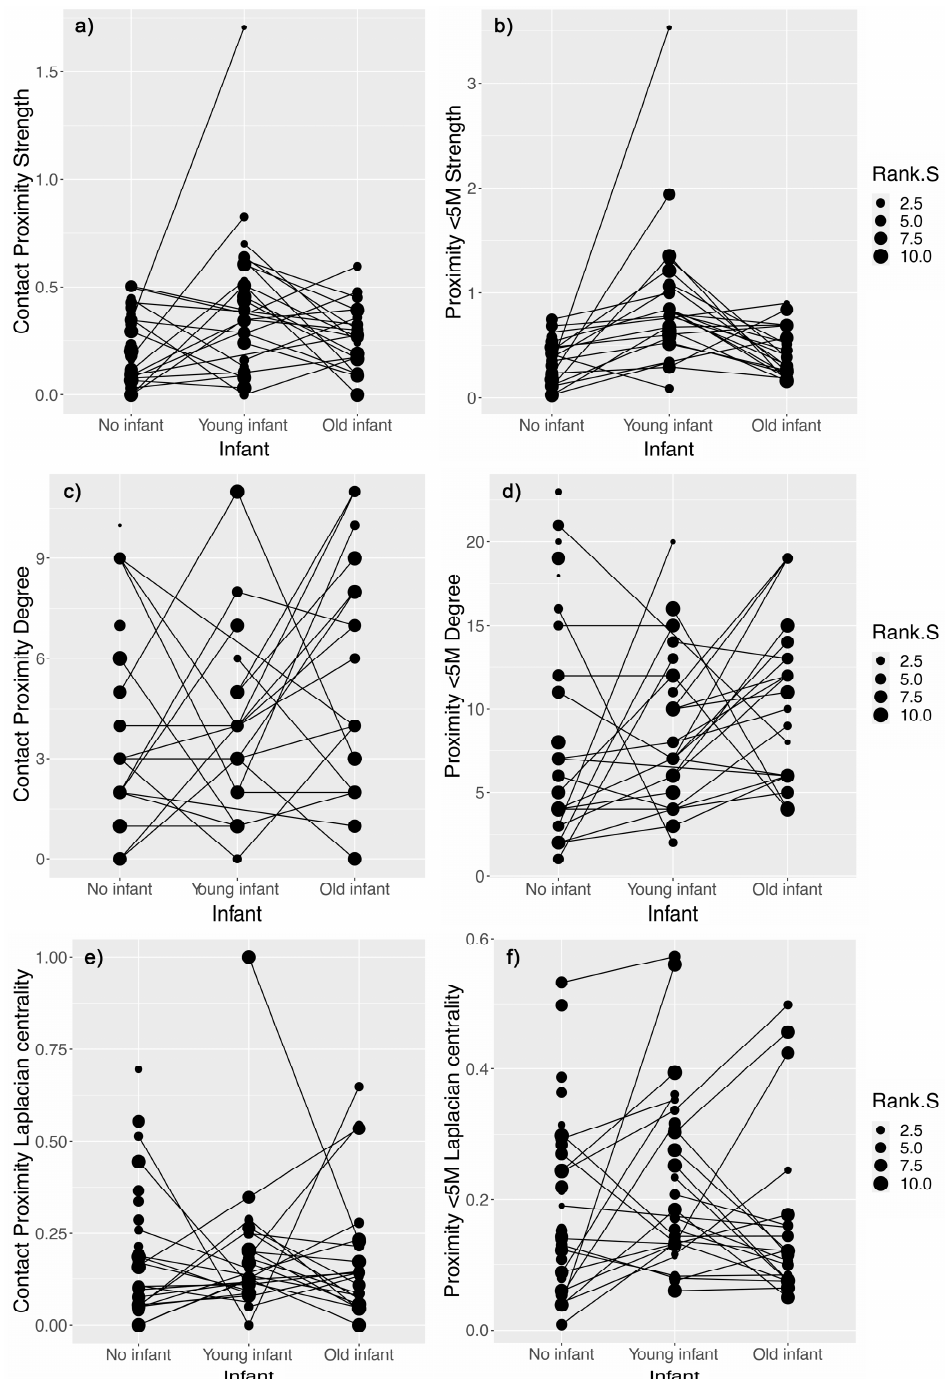
Figure 1. Comparison of the ( a,b ) frequency in association ( Strength ), ( c , d ) number of female neighbors ( Degree ) and ( e , f ) connectivity power ( Laplacian centrality ) between female nursing conditions (No infant (NN) vs Young infant (YI) vs Old infant (OI) females) of the contact- ( a,c,e ) and 5 m proximity networks ( b,d,f ). Node size reflects the hierarchical rank (the lowest values represent the highest-ranking individuals). The lines represent the same individual experiencing different nursing conditions in the course of the study. Because several individual data points could overlap, more than two lines could start from the same dot.